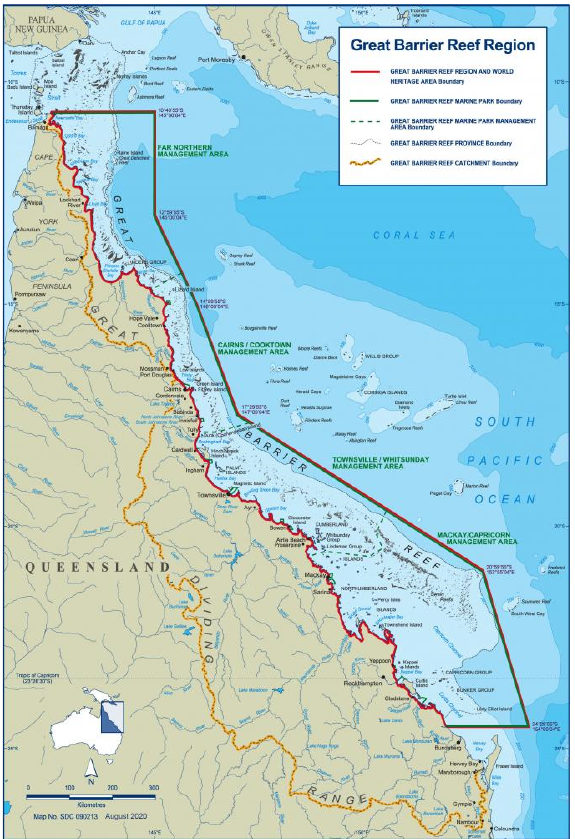
Figure 8. Great Barrier Reef Marine Park Extent of Park and catchments. https://www.transparency. gov.au/annual-reports/great-barrier-reef-marine-park-authority/reporting-year/2019-20-4, ac- cessed on 10 April 2022. This study considered the region outlined by the red boundary.